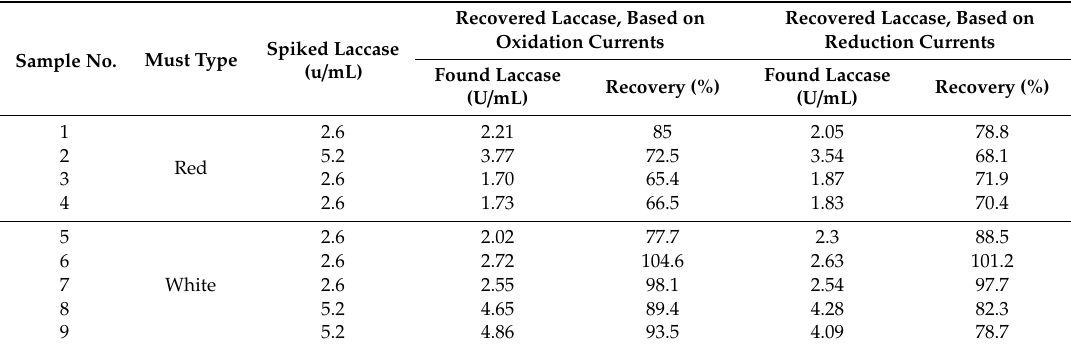
Table 1. Results of evaluating the laccase content of must samples spiked with known concentrations of laccase. The laccase activity was determined using both oxidation currents (at + 0.4 V) and reduction currents (at 0